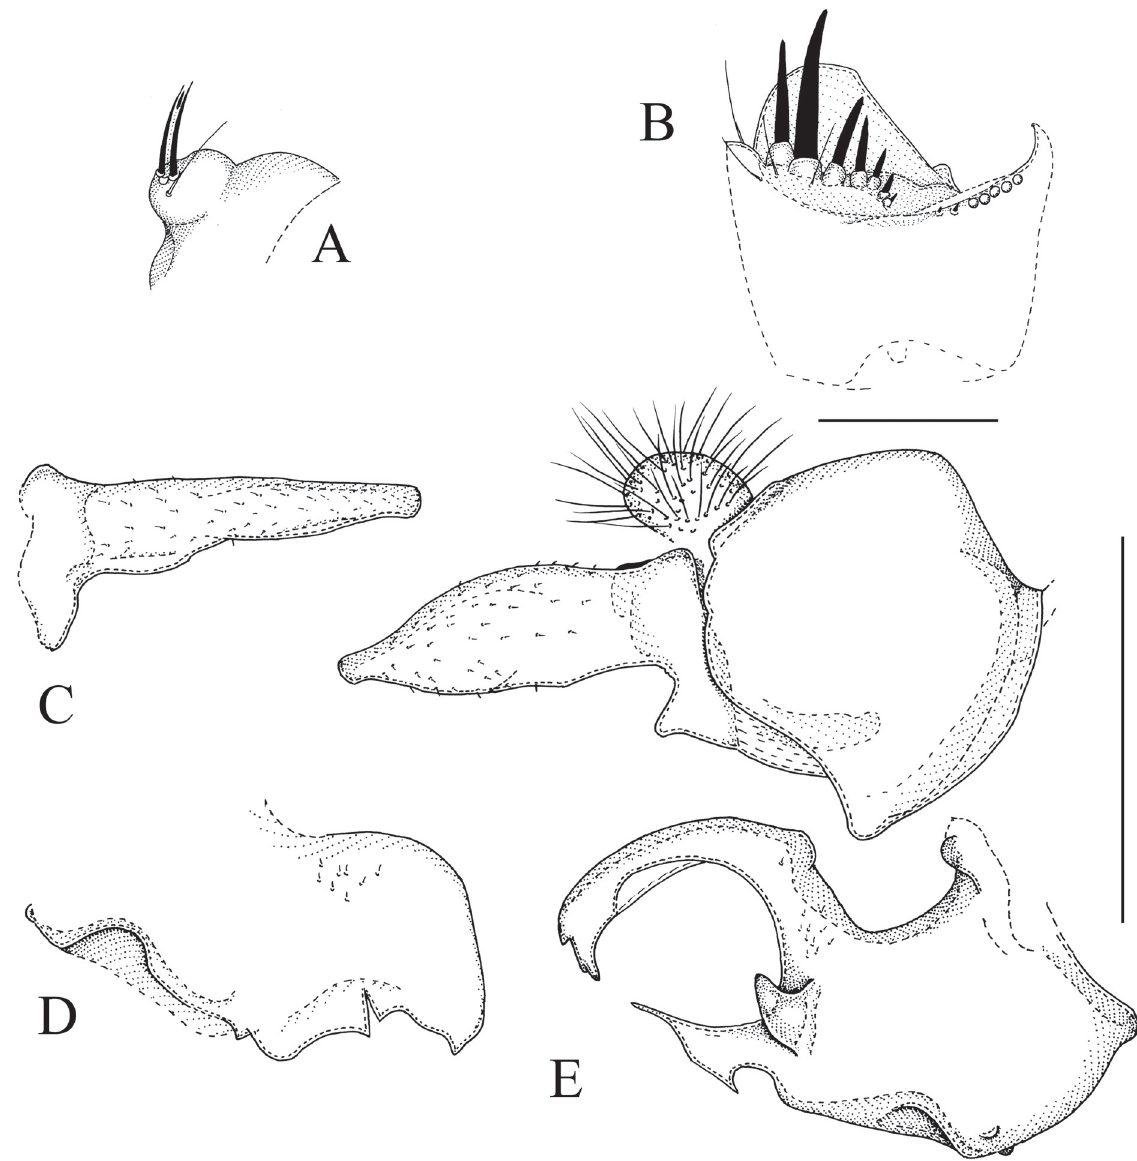
Fig. 81. Sphegina (Asiosphegina) setosa sp. nov., paratype, ♂ , India. A . Sternum VII, ven tral view. B . Sternum IV, ventral view. C . Left surstylus, lateral view. D . Left superior lobe with associated